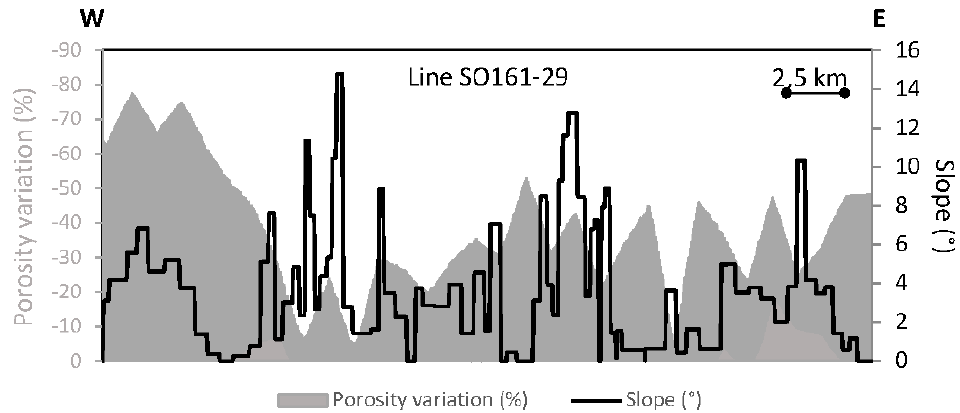
Figure 5. Porosity variations due to the gas hydrate presence (grey area) and slope variation (black line) along the line SO161-29.